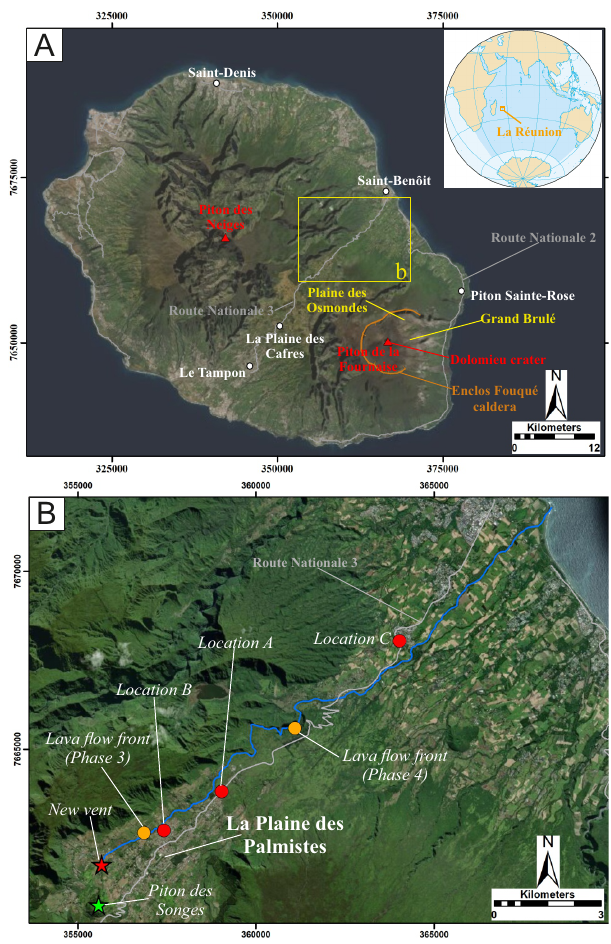
Figure 1: [A] La Réunion island; [B] enlargement of [A] with the indication of key elements for the target ques- tions described in Section 3.1.2 . Grey lines are main roads, the blue line is the line of steepest descent, the orange dashed line is the limit of the Enclos Fouqué caldera. Coordinates are expressed in the UTM-WGS84 40S system. Service Layer Credits, source: Esri, Digi- talGlobe, GeoEye, Earthstar Geographics, CNES/Airbus DS, USDA, USGS, AeroGRID, IGN and the GIS User Com-